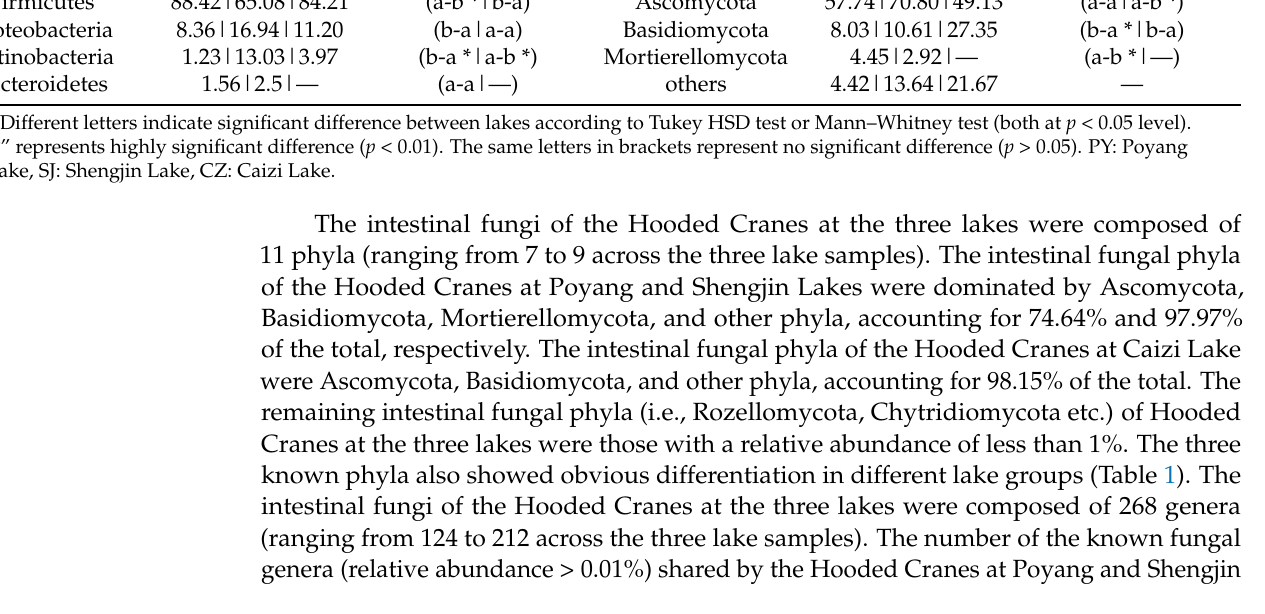
Table 1. Relative abundance of the dominant intestinal bacterial and fungal phyla of the Hooded Cranes at the three lakes. Average Relative Abundance (%) Phyla